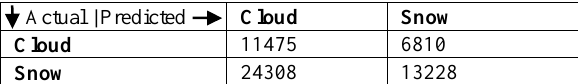
Table 2. Confusion matrix of the test tile